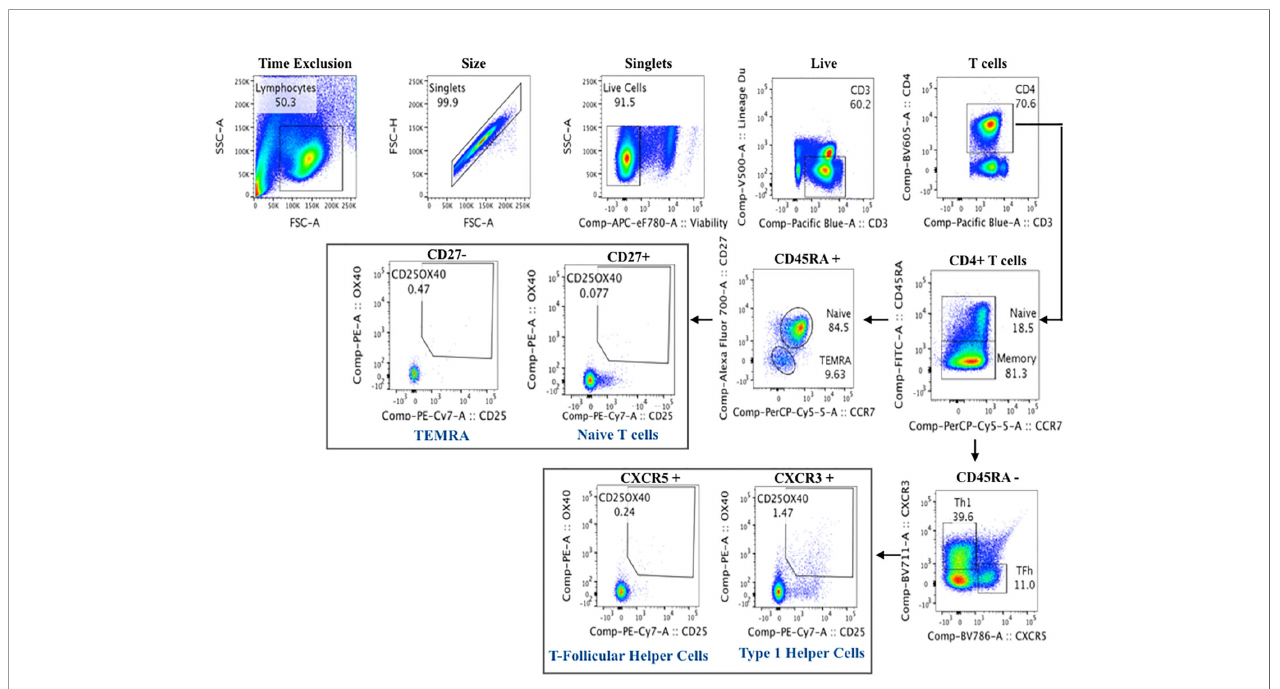
FIGURE 5 | Flow cytometry gating strategy of activated T cells for cell mediated immunity assay to Hepatitis B.